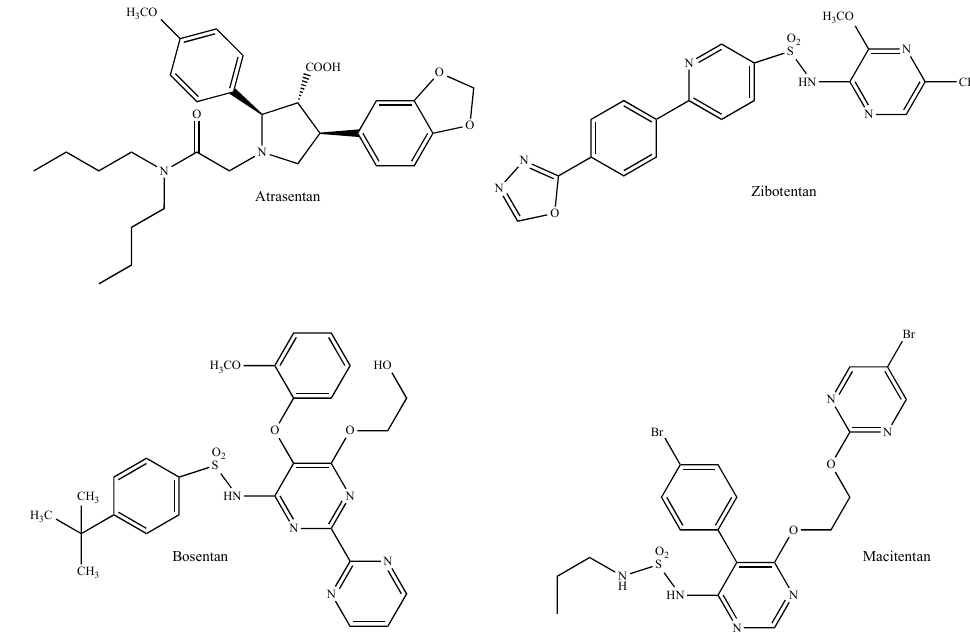
Figure 11. Structure of the ETAR antagonists atrasentan, ziboentran, bosentran and macitrentan.